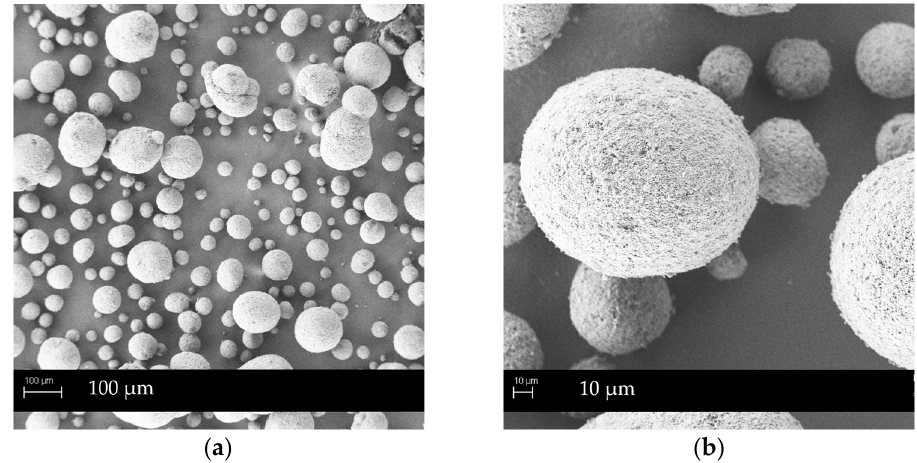
Figure 1. SEM images of Neusilin ® US2 particles: ( a ) under magnification 200×; ( b ) under magnifi- cation 1000×.